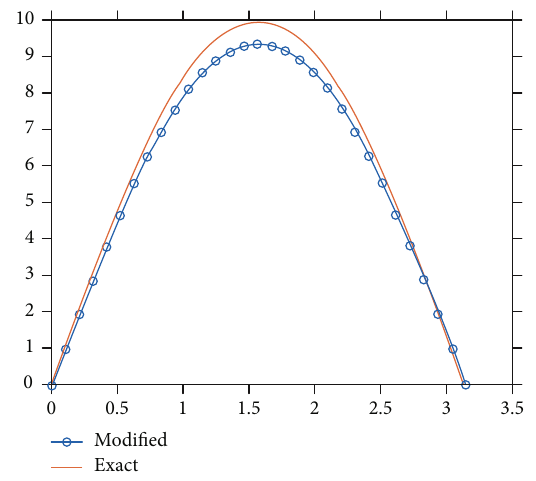
Figure 6: The disparity between the exact solution of the system of equations (2) – (5) and the regularized solution of the system of equations (12) – (15) for p = 2 and k = 0 : 5